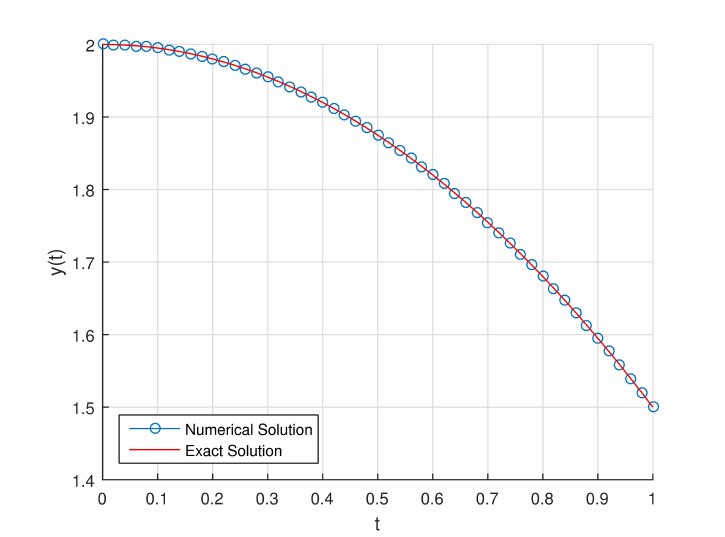
Figure 14. The behaviour of the numerical and exact solutions with m =